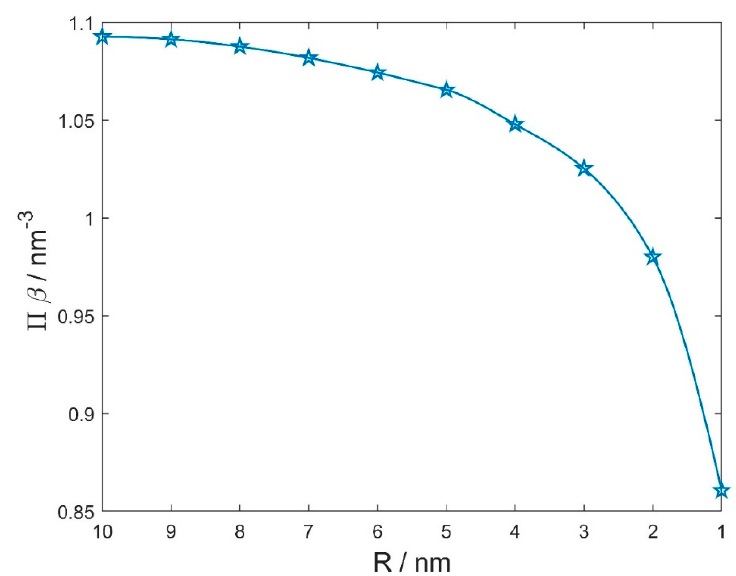
Figure 6. The calculated (net) osmotic pressure between two negatively charged neighbouring spheres/vesicles embedded in a electrolyte solution as a function of the radius of the smaller sphere/vesicle ( R ). The radius of the larger sphere/vesicle R p = 10 nm (see also Figure 4). The distance between the spheres/vesicles is H = 1 nm for all values of R . Both spheres have equal surface charge densities ( σ = − 0.25 As/m 2 ). The value of the osmotic pressure for R = 10 nm corresponds to the case where both spheres/vesicles have the same radius (Figure 5). The values of other model parameters are the same as in Figure 5. Note that Equation (8) has limited validity for small values of 𝑅 .